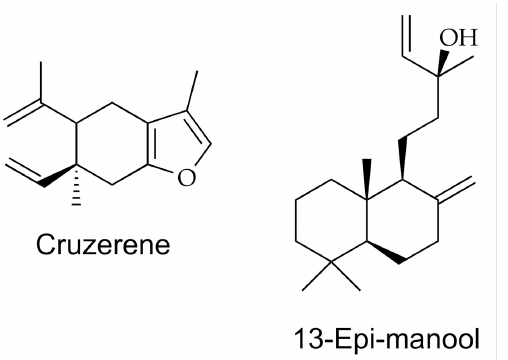
Figure 6. The chemical structure for curzerene and 13-epi-manool, components of myrrh and copal resins, respectively.